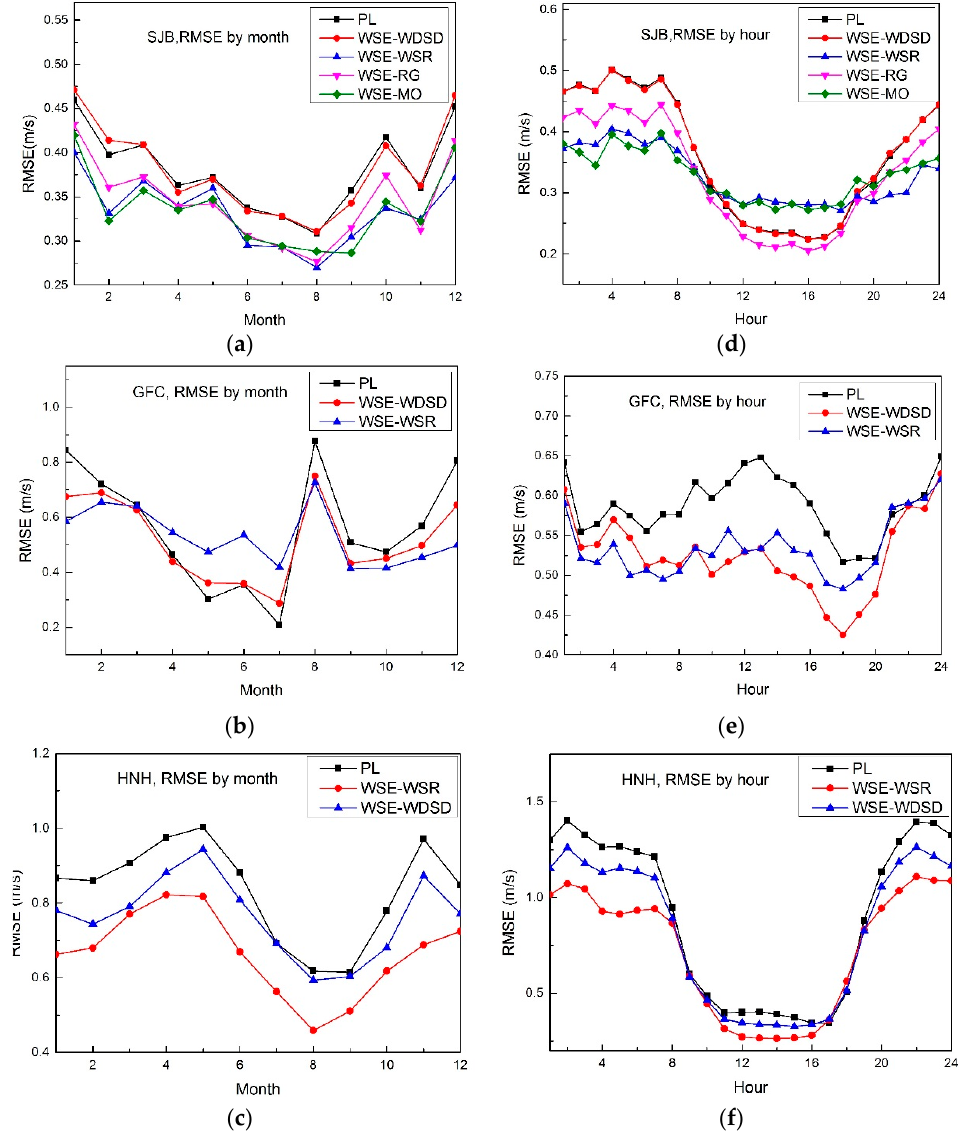
Figure 6. ( a – c ) Monthly and ( d – f ) daily variations of RMSE using different methods in the three different cases.